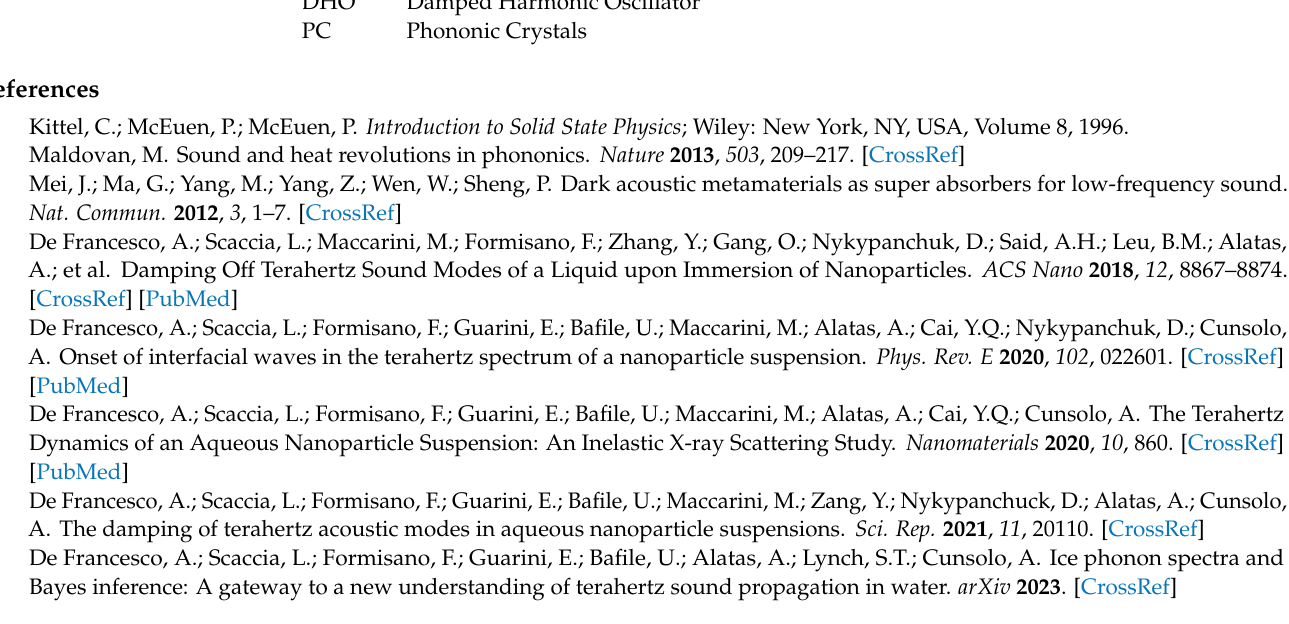
Figure S6: Comparison between the IXS spectra measured at Q = 7 nm − 1 on the ice sample and the frozen suspension; Figure S7: Comparison between the IXS spectra measured at Q = 5 nm − 1 on the ice sample and the frozen